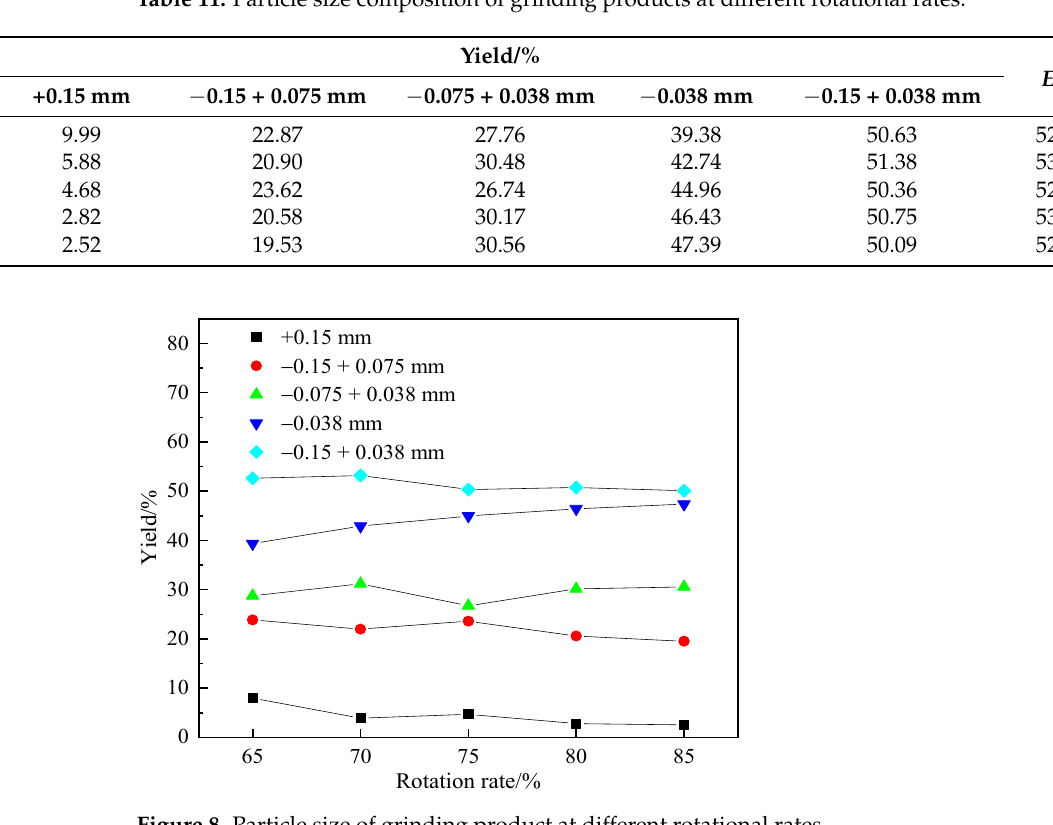
Table 11. Particle size composition of grinding products at different rotational rates.